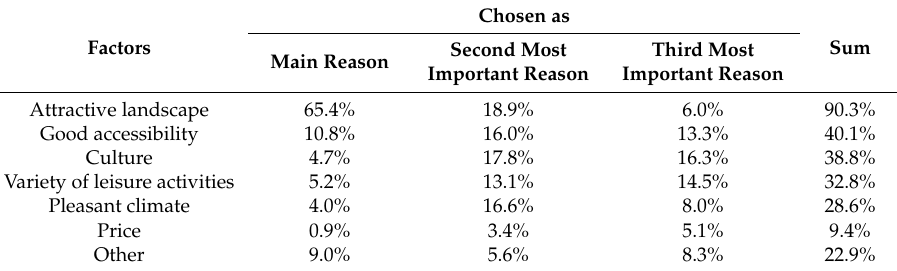
Table 2. Factors for destination choice.